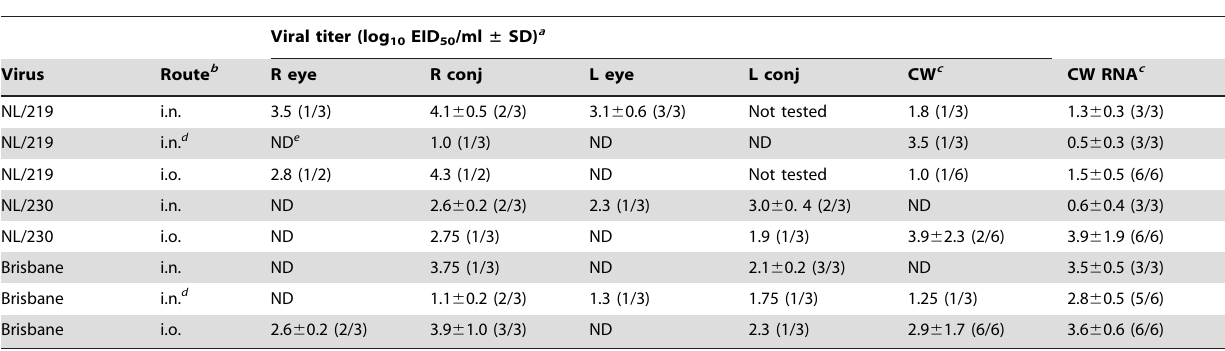
Table 4. Comparative viral pathogenesis between intranasal and ocular inoculation day 3 p.i. in ocular tissue.